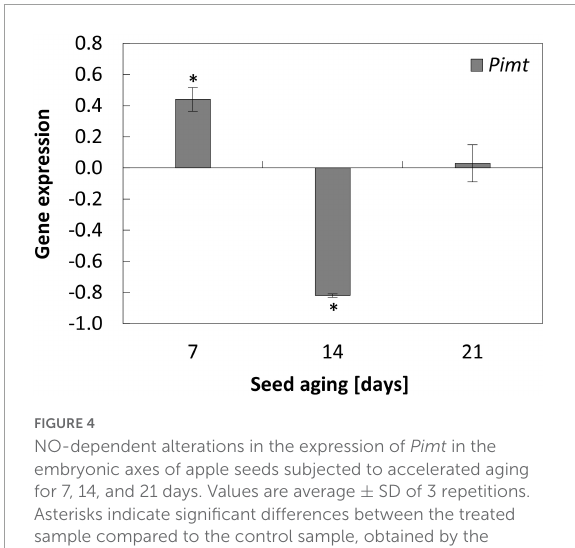
FIGURE5 NO-dependent alterations in the expression of Tor and Raptor in the embryonic axes of apple seeds subjected to accelerated aging for 7, 14, and 21 days. Values are average ± SD of 3 repetitions. Asterisks indicate significant differences between the treated sample compared to the control sample, obtained by the Student’s t -test ( P <